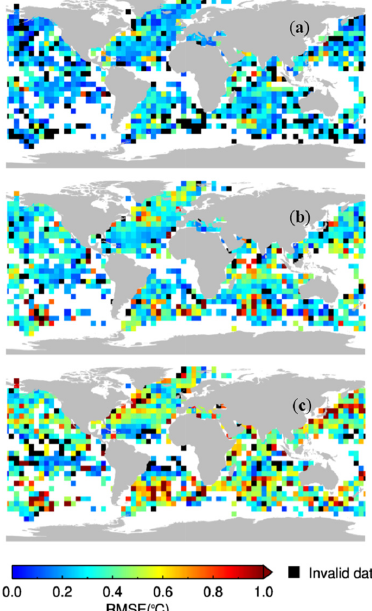
Figure 4. Global maps of root mean square errors (°C) in 5° × 5° resolution for ( a ) drifter measured SST; ( b ) NAVO S-NPP VIIRS SST; and ( c ) AQUA MODIS SST derived from three-way error analysis.